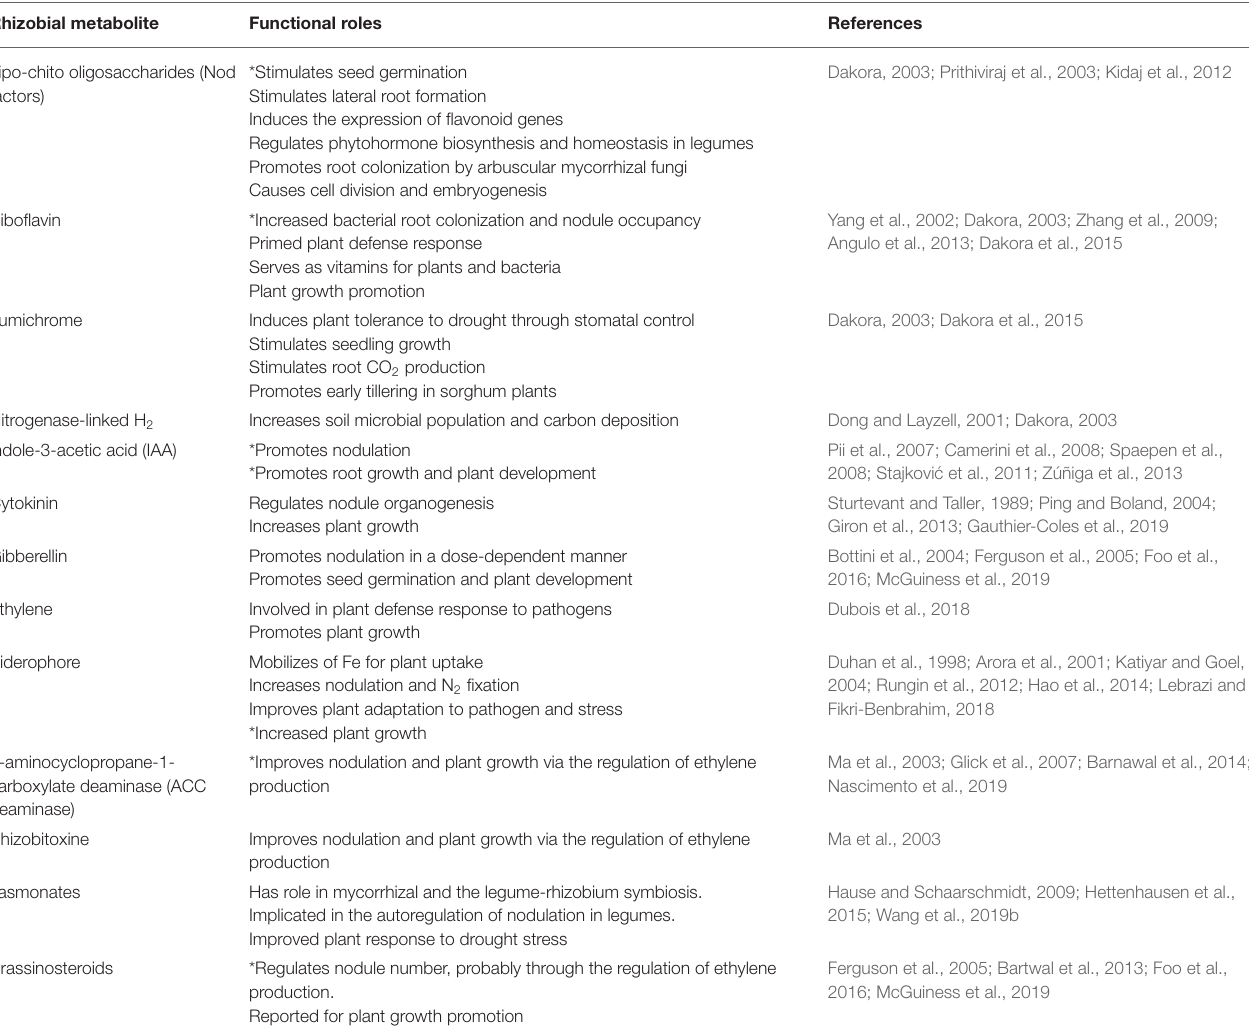
TABLE 1 | Rhizobial metabolites and their functional roles in plant growth and